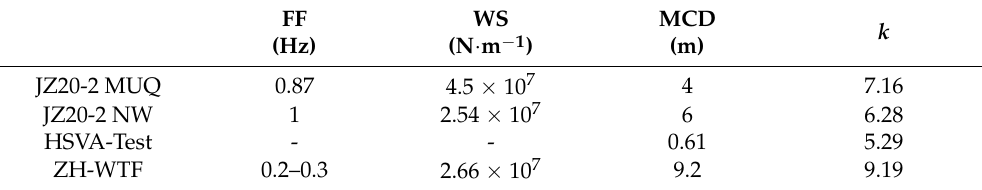
Table 3. Structural characteristics of different anti-ice cones and their length–thickness ratios, k .